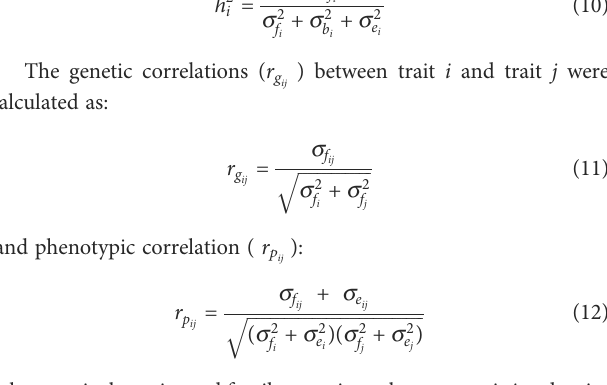
FIGURE 1 Variation in the a pinene, b pinene, abietic acid and levoprimaric acid contents. The minimum, maximum, and average values of each pine resin component content in the slash pine population were marked at the bottom, top, and middle of each boxplot,